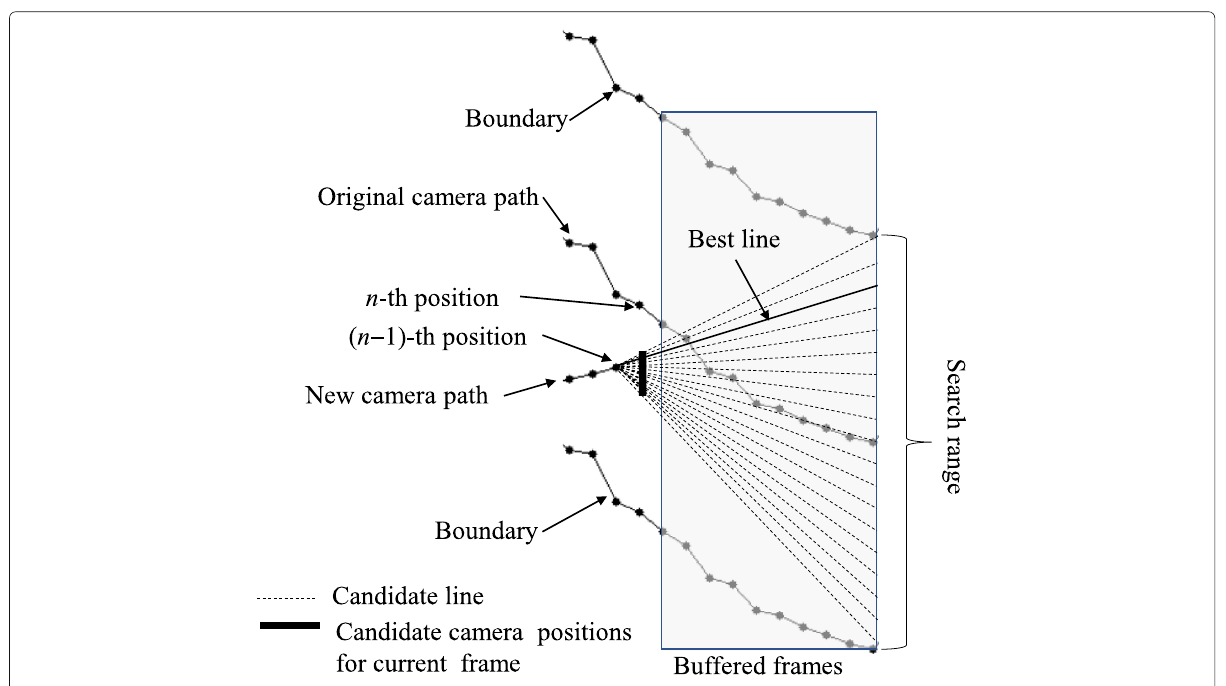
Fig. 6 Possible candidate